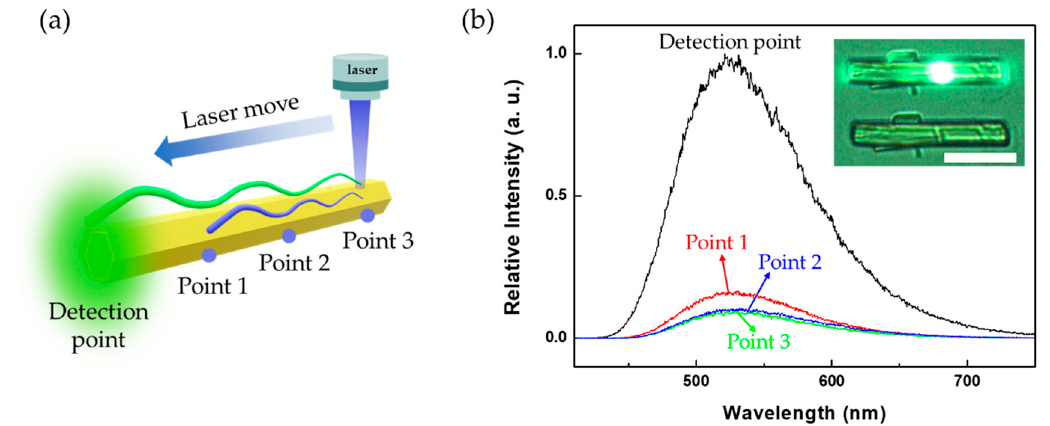
Figure 5. ( a ) Schematic illustration of an optical waveguide with a movable laser and fixed detector system. ( b ) PL waveguide spectra of single Alq 3 MCs ( λ ex: 405 nm, scale bar: 5 μ m).